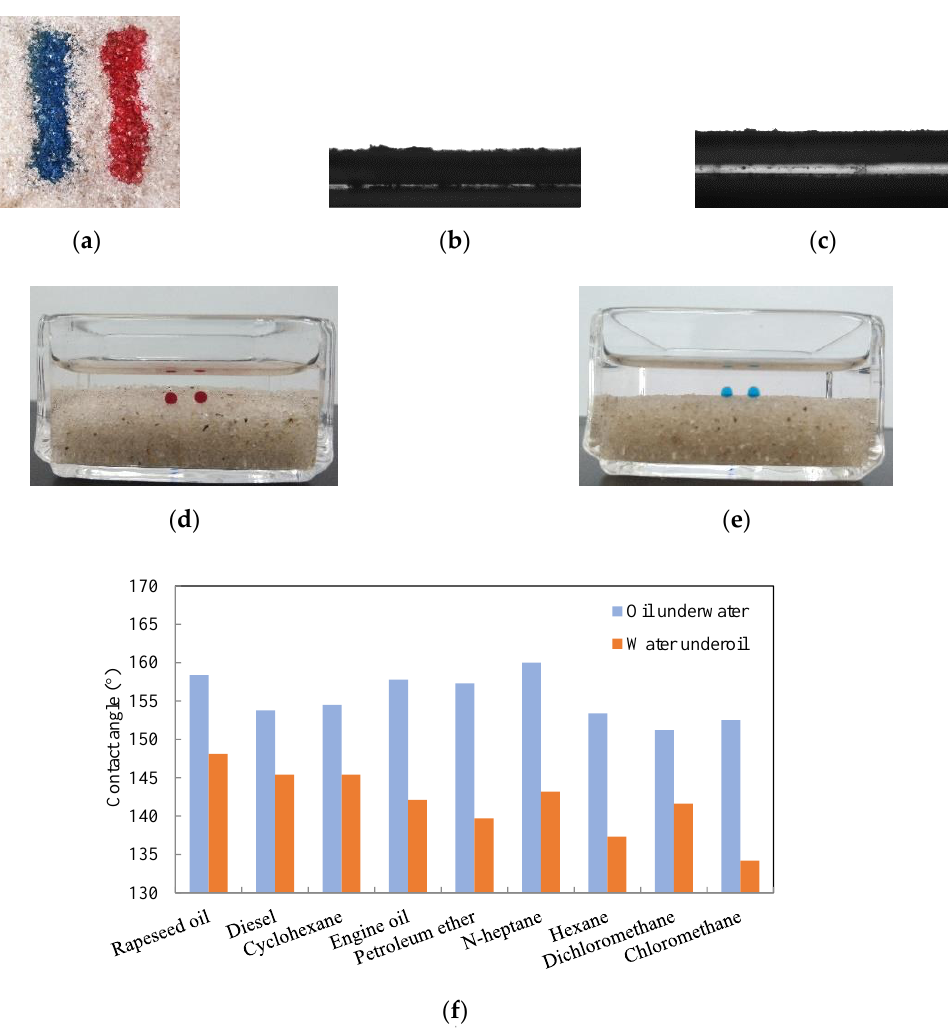
Figure 4. The contact angle of CSQS. ( a ) Water droplets (colored blue by methylene blue) and oil droplets (colored red by oil red O) on the CSQS surface in air, respectively; ( b ) the water contact angle is 0°; ( c ) the oil contact angle is 0°; ( d ) contact angle picture of dichloromethane underwater on CSQS surface; ( e ) contact angle picture of water under cyclohexane on CSQS surface; ( f ) contact angles of water under oils and oils under water.